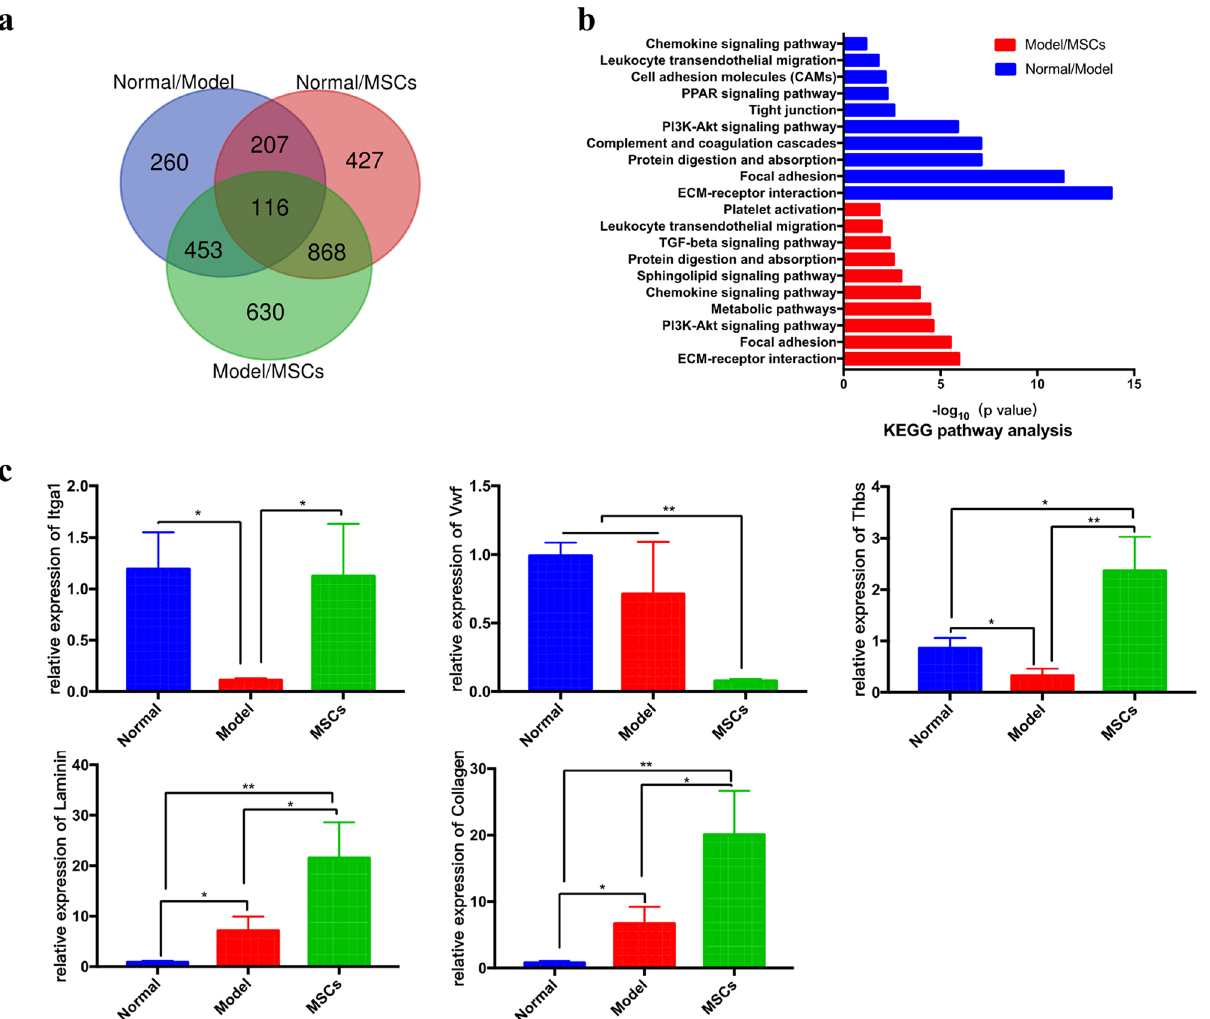
Figure 5. Relationship and functional analysis of differentially expressed mRNAs. ( a ) Venn diagram of genes differentially expressed in Normal/Model, Model/MSCs and Normal/MSCs groups. ( b ) KEGG pathway analysis 36 of Normal/Model and Model/MSCs groups measured by mRNA microarray chip. ( c ) qRT-PCR verification of differentially expressed genes in ECM-receptor interaction signal pathway (These genes were obtained from MAP04512 and MAP04510 of KEGG: https:// www. kegg. jp/ kegg/). * p < 0.05, ** p <